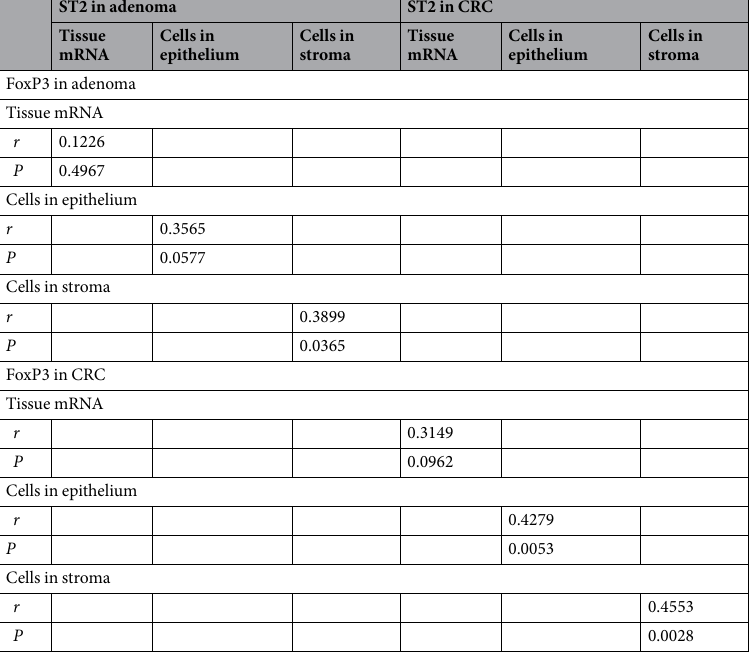
Table 1. Spearman’s R coefficient analysis of correlation between ST2 and FoxP3 at mRNA and cellular levels in the adenoma/CRC